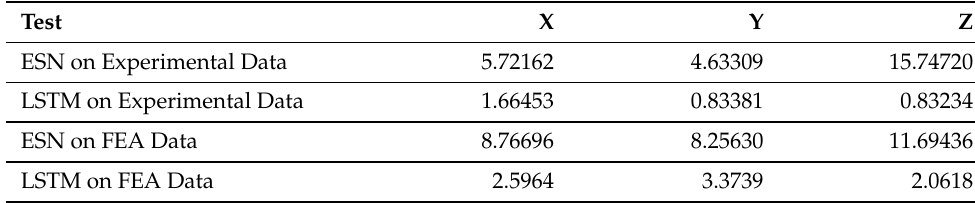
Table 3. Test errors for ESN and LSTM networks on experimental and FEA